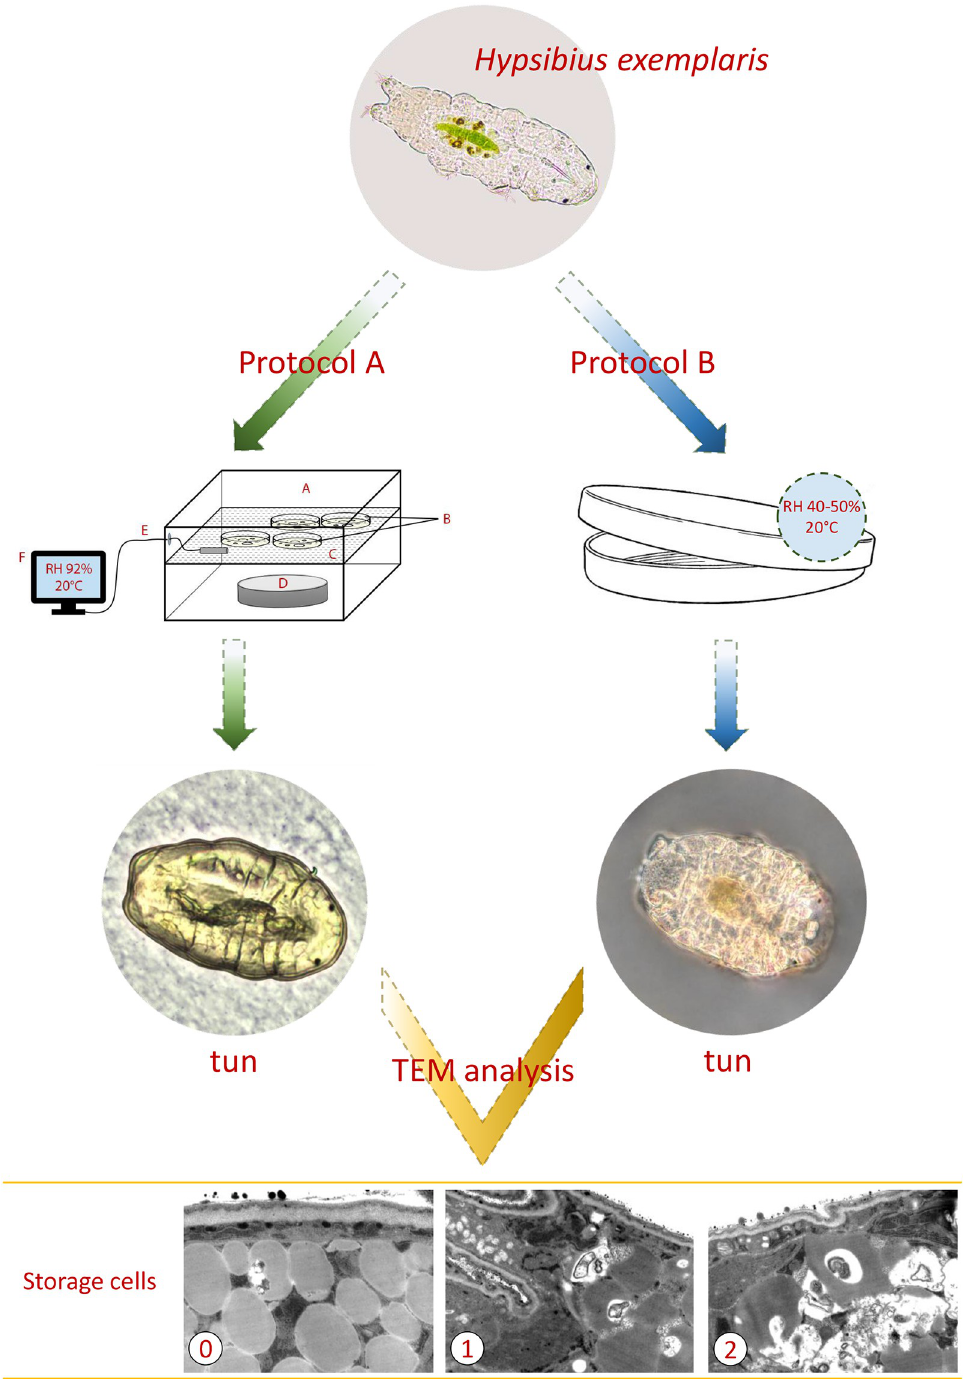
Fig 1. Scheme of the experimental setup of A and B protocols used for ultrastructural analyzes. Protocol A is represented by the sketch of preconditioning procedure and protocol B by a plate used for slow dehydration. A . small plastic box with lid; B . 2% agar-coated lids of Petri dishes (“agar plates”); C . scaffold for agar plates; D . a glass watch dish containing 10% glycerol solution; E-F . digital hygrometer; TEM, transmission electron microscopy; 0, 1 and 2, the distinguished three stages of degeneration of storage cells in typical tuns. High definition images obtained using TEM analysis, with relevant scale bars added, are presented in Fig 3.